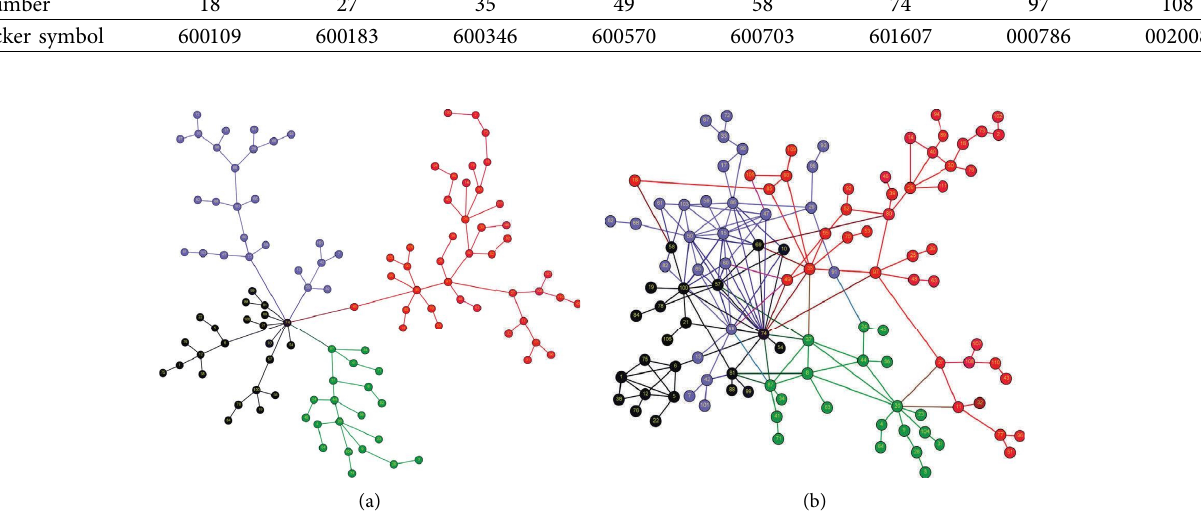
Figure 3: Te MST and threshold network. (a) MST. (b) Treshold network.